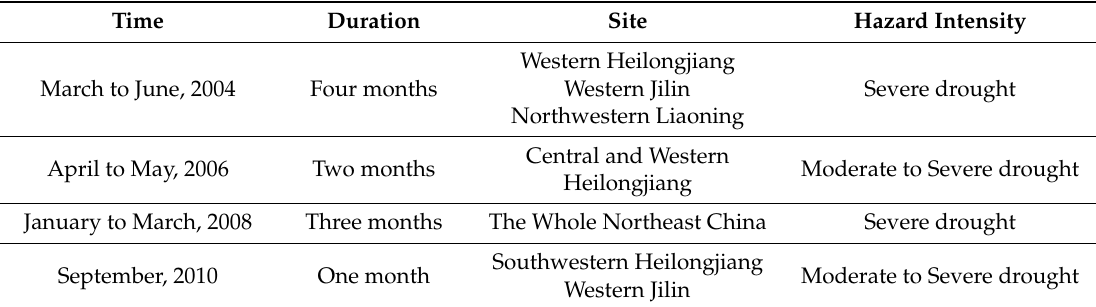
Table 1. Record of the Drought Events in 2004–2010 by China Meteorological Disaster Yearbook.